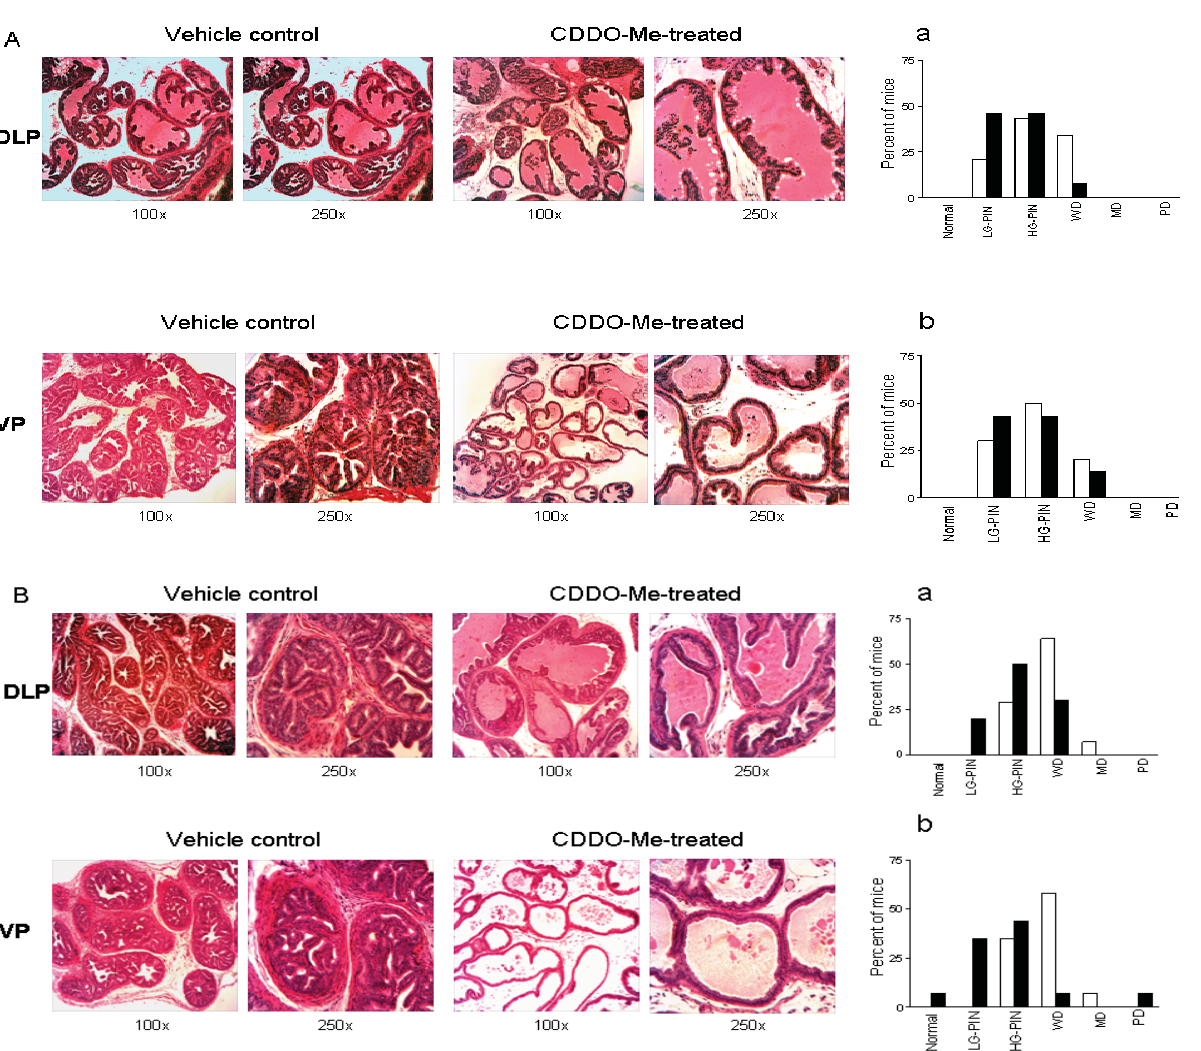
Figure 3. (A) . H&E-stained sections of DLP and VP of a 12 wk old vehicle control or CDDO-Me treated TRAMP mouse. Control and CDDO-Me treated DLP showing HG-PIN and LG-PIN lesions, respectively. Control and CDDO-Me treated VP showing well differentiated carcinoma (MD) and LG-PIN, respectively. Bar graphs show distribution of histologic grades (normal, LG-PIN, HG-PIN, WD, MD or PD carcinoma) in DLP and VP of control and CDDO-Me treated TRAMP mice (n = 14); ( B) . H&E-stained sections of DLP and VP of a 25 wk old vehicle control or CDDO-Me treated TRAMP mouse. Control and CDDO-Me treated DLP showing well differentiated carcinoma (MD) and HG-PIN lesions, respectively. Control and CDDO-Me treated VP showing MD and